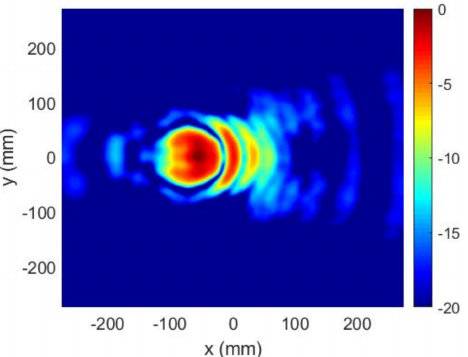
Figure 6. Case 1, Stage#1: near field ( E (cid:48) NF ) at z = D (normalized amplitude, dB).